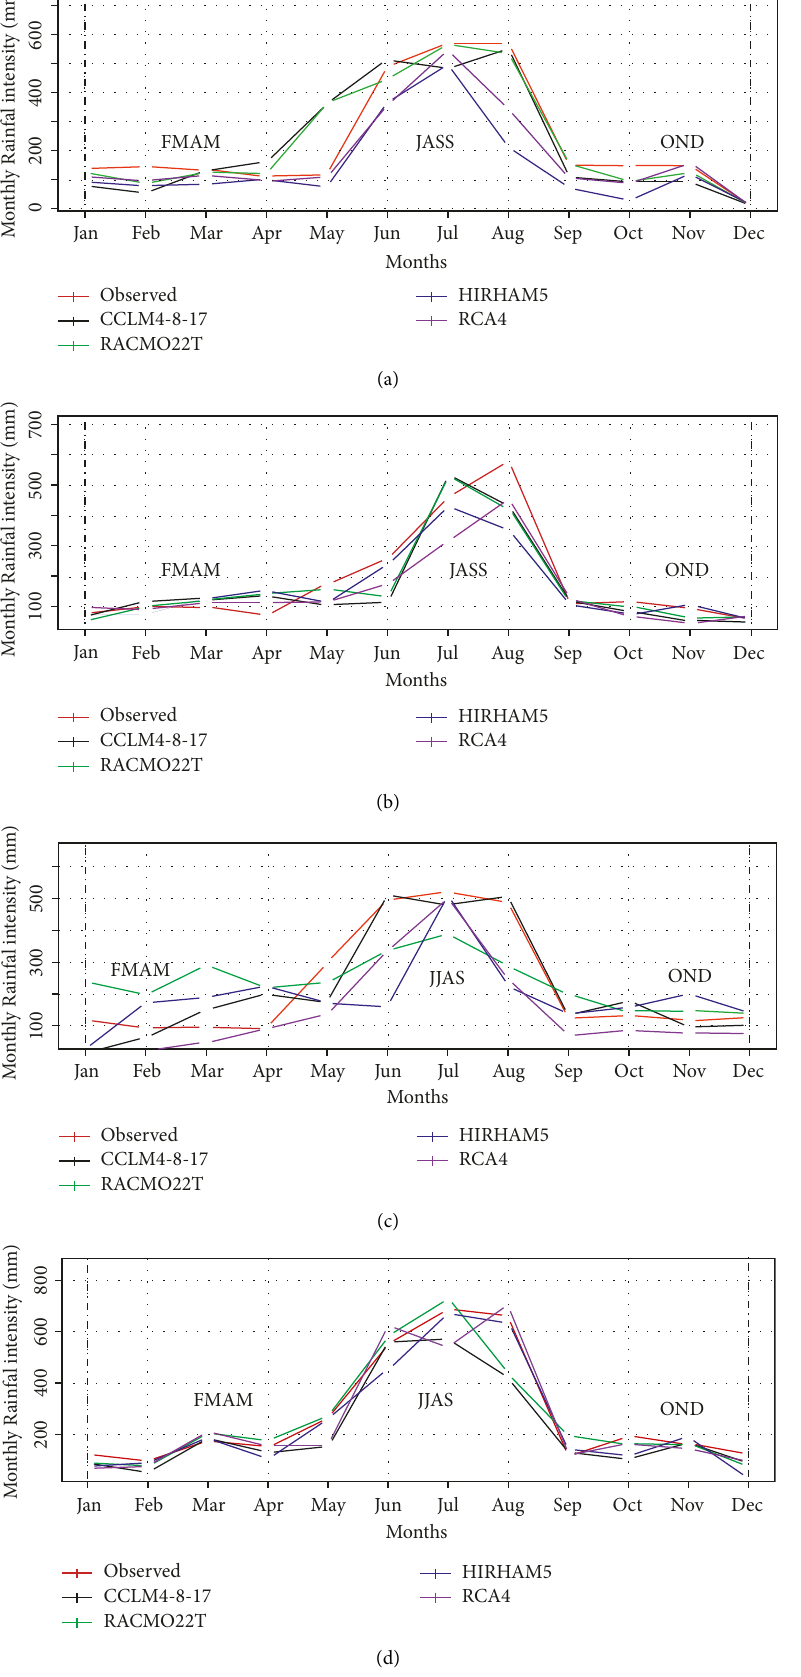
Figure 8: Mean annual cycle analysis of precipitation based on rain season occurrences from